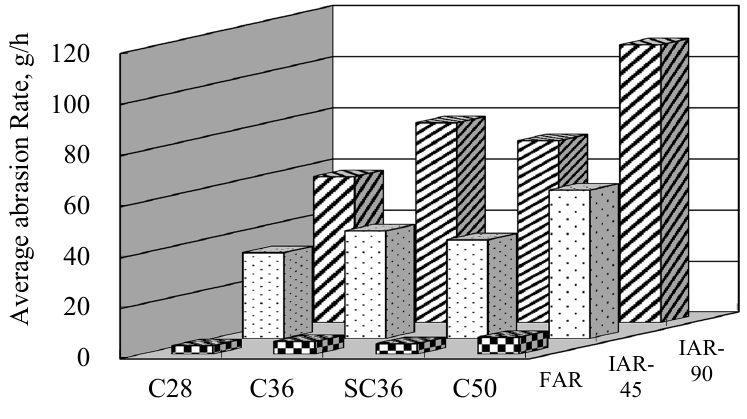
Figure 13. FAR and IAR of concrete.